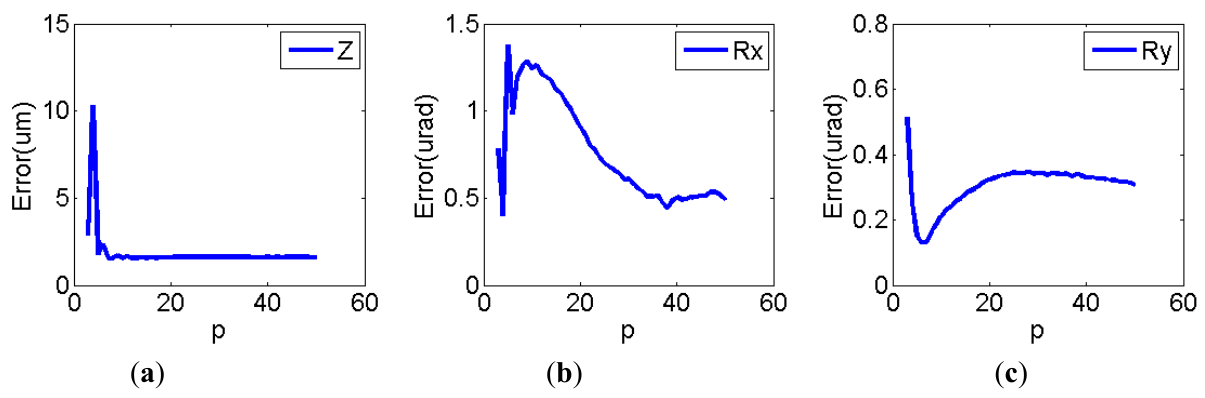
Figure 4. Estimation error changes with p -value when reference input was applied in